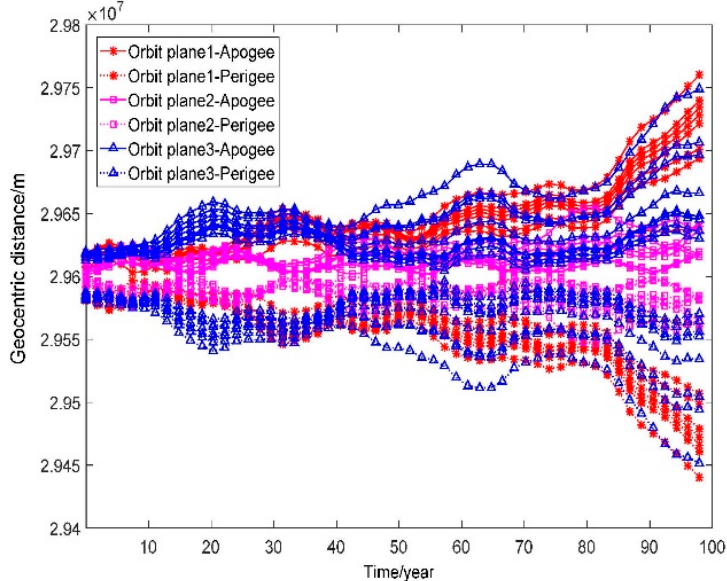
Figure 4. Orbital variations of Galileo satellites over 100 years. From the above graph we can see that the orbits of the 24 Galileo satellites are relatively safe; they will not intersect with other GNSS constellations over the next 100 years. The spent upper stages of the Galileo system mainly include FREGAT R/B and ARIANE 5 R/B. In the early stage, the upper stages were usually disposed of by raising the orbital altitude. In the year after 2016, the upper stages have typically been disposed of by reducing the orbital altitude. The orbit of the upper stage numbered 40130 has already crossed over into the Galileo, BDS, GPS, and GLONASS constellations. Table 2 shows the orbital parameters of the upper stage numbered